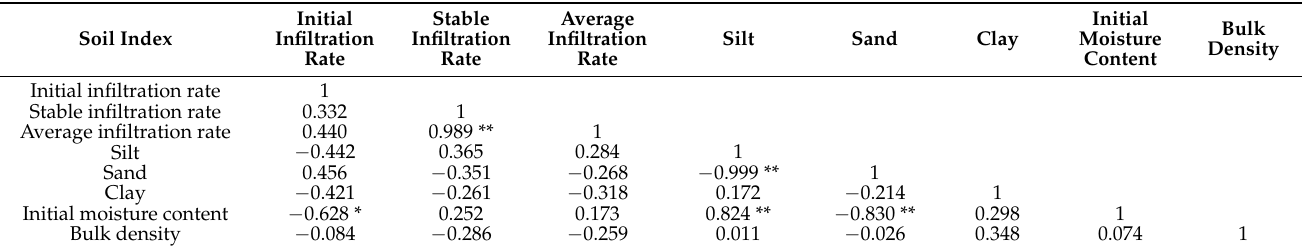
Table 3. Correlation analysis between soil infiltration characteristics and soil